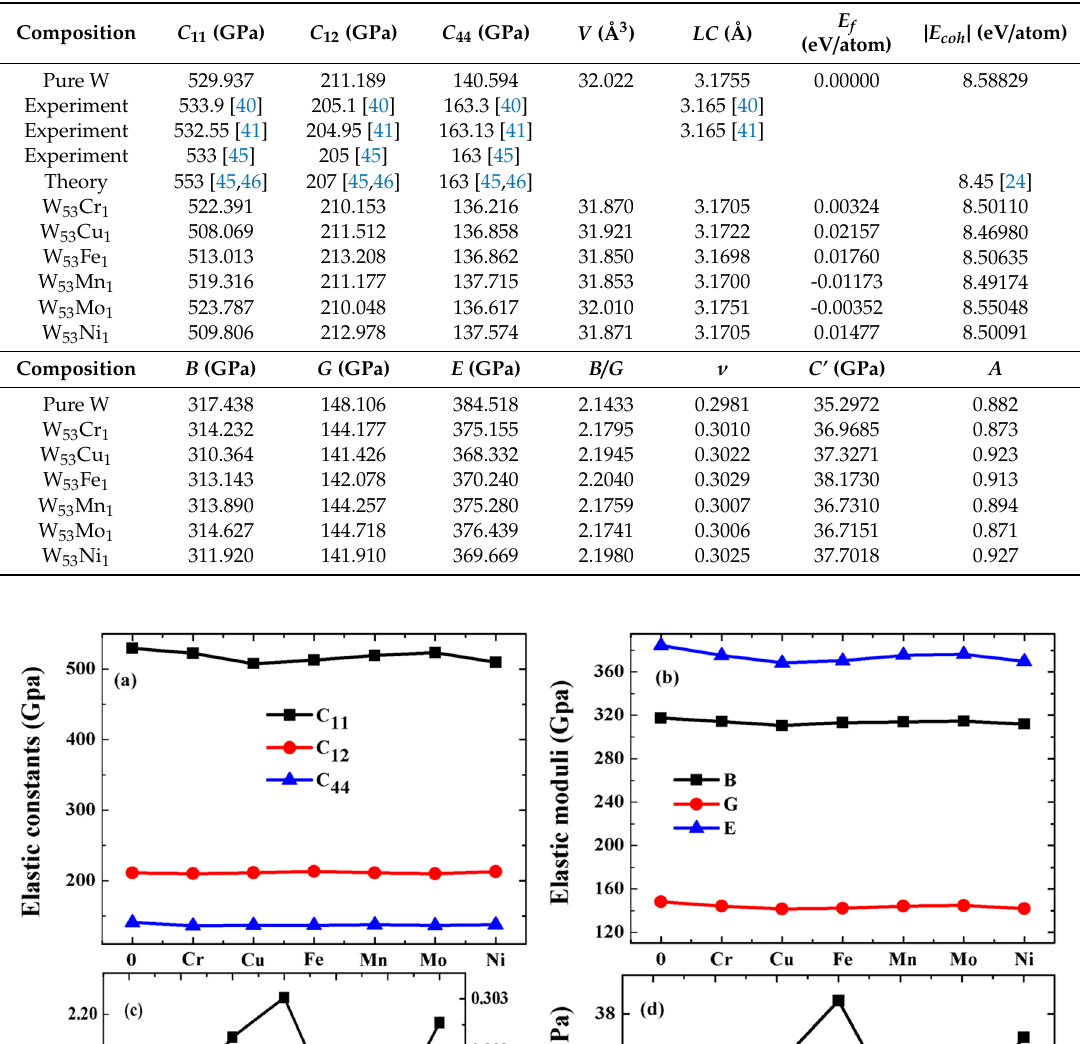
Table 2. The elastic constants ( C ij ), Cell volumes ( V ), Lattice constants ( LC ), Formation energies ( E f ), Cohesive energies ( E coh ), Bulk modulus ( B ), Shear modulus ( G ), Young’s modulus ( E ), B / G ratio, Poisson’s ratio ( ν ), Cauchy pressures ( C ’) and Anisotropic coe ffi cients ( A ) of TM (TM = Cr, Cu, Fe, Mn, Mo and Ni) impurities in W.